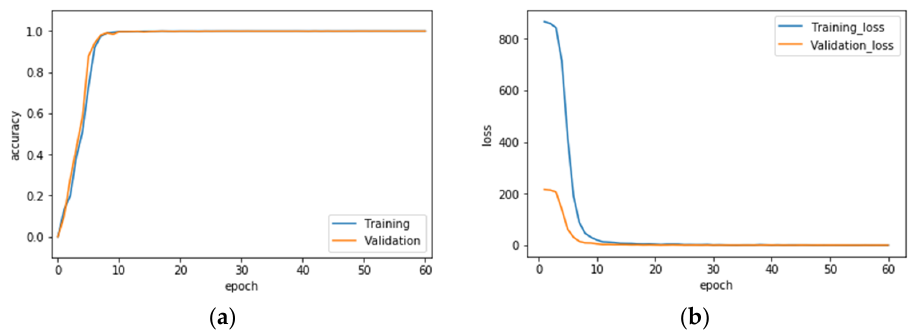
Figure 20. Recognition rate ( a ) and loss value ( b ) curves of the VGG-16 CNN model training using min-max wavelet fused images.